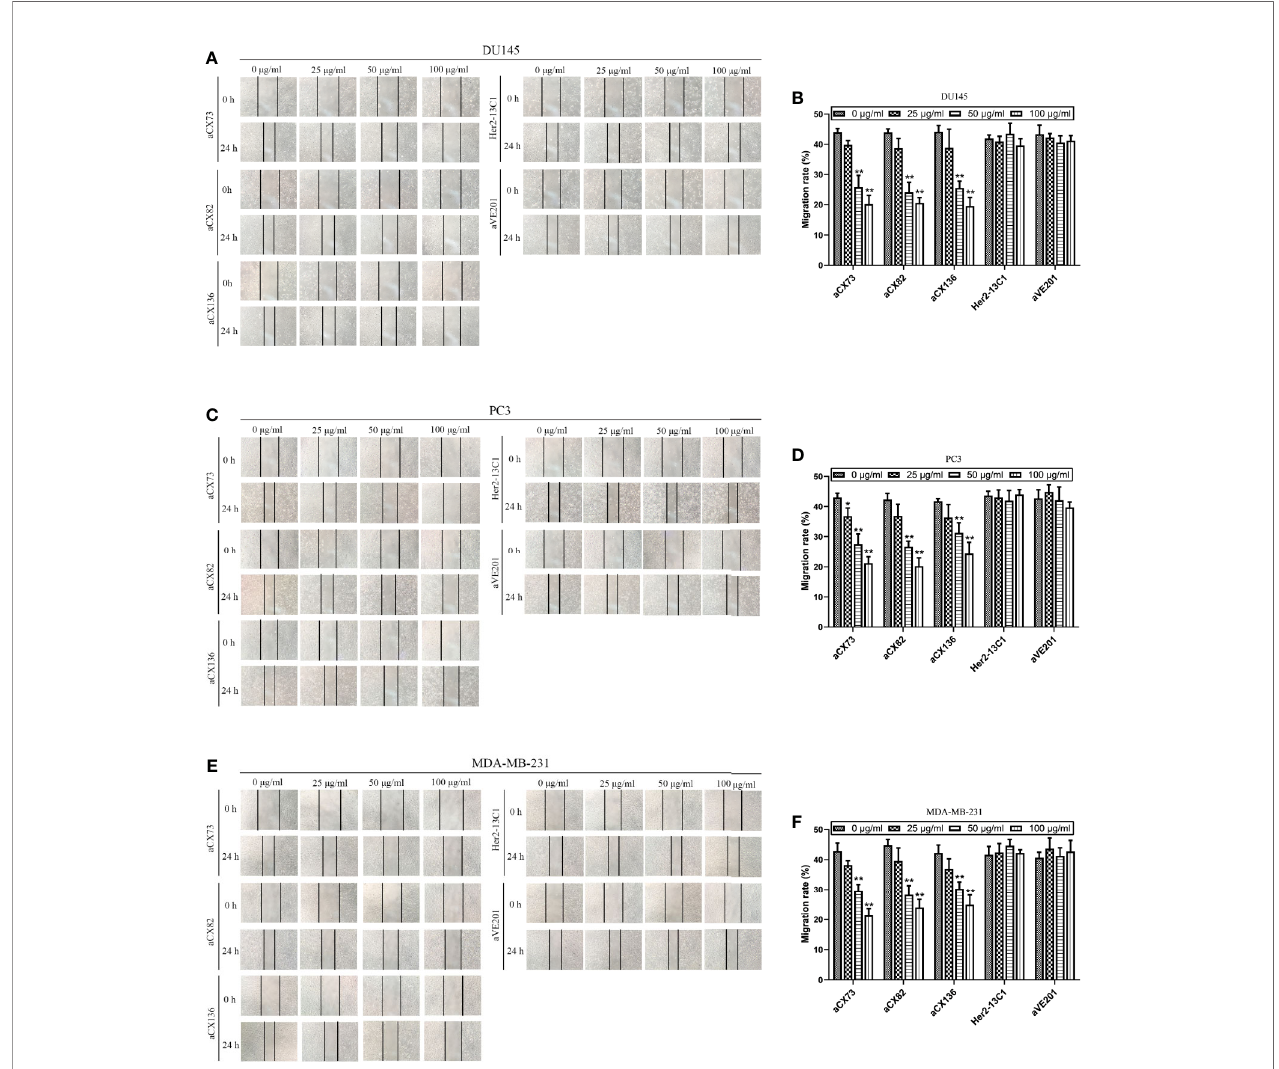
FIGURE 8 | Anti-CXCR4 scFvs can decrease cell migration detected by wound healing assay. Cells were cultured with CXCL12 (100 ng/ml) and the three anti- CXCR4 scFvs (aCX73, aCX82, and aCX136) or negative control antibodies (Her2-13C1 and aVE201). Images were taken at 0 and 24 h after the cell wounds were made. The wound widths were determined. (A, B) DU145; (C, D) PC3; (E, F) MDA-MB-231. The results represent mean ± S.D (n=5). * P < 0.05 and ** P